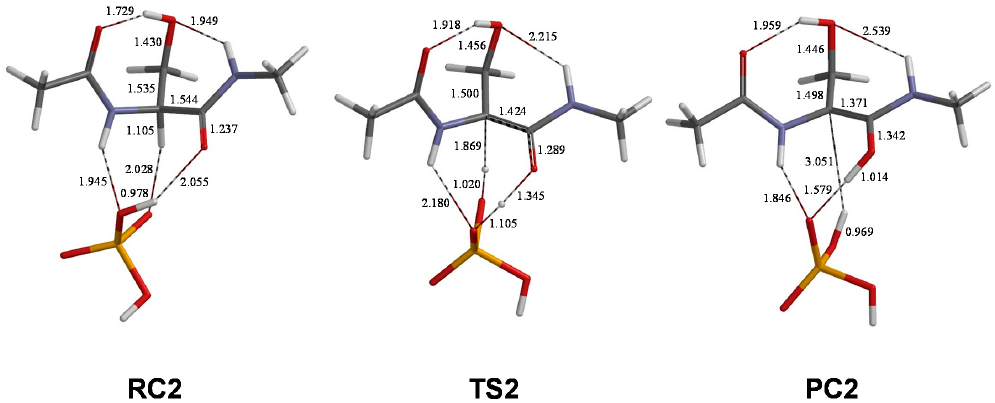
Figure 4. The geometries of RC1 (reactant complex of pathway 1), TS1 (transition state of pathway 1), and PC1 (product complex of pathway 1). Selected interatomic distances are shown in Å. Grey: carbon; white: hydrogen; blue: nitrogen; red: oxygen; orange: phosphorus.